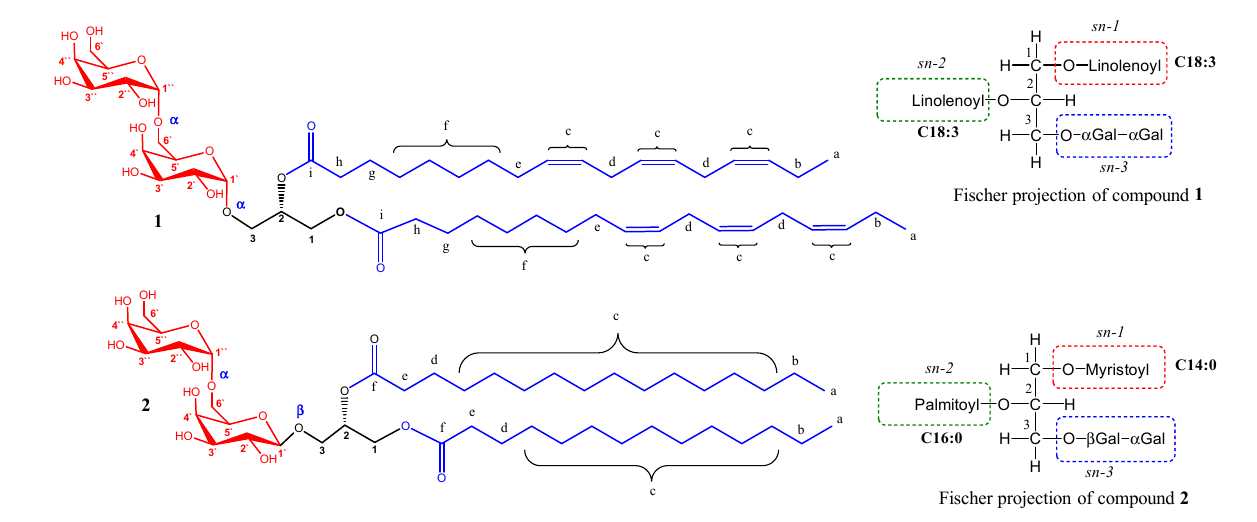
Figure 2. Structures of compounds 1 and 2 isolated from Launaea capitata . Table 1. 1 H (500 MHz, CD 3 OD) and 13 C (125 MHz) NMR spectral data of compound 1 ( J in